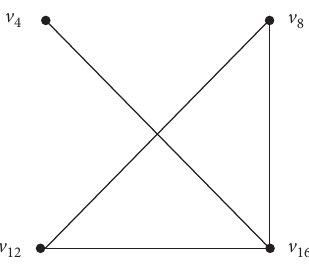
Figure 7: Graph G I ( Λ ), where Λ = < 4, 5, > and I is an irreducible ideal with x =16.